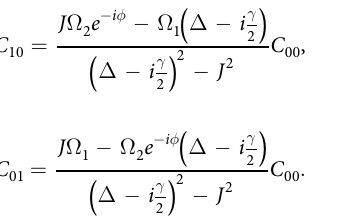
Now, sustituting Eqs (19) and (20) into Eqs (16–18), we obtain the following matrix equation